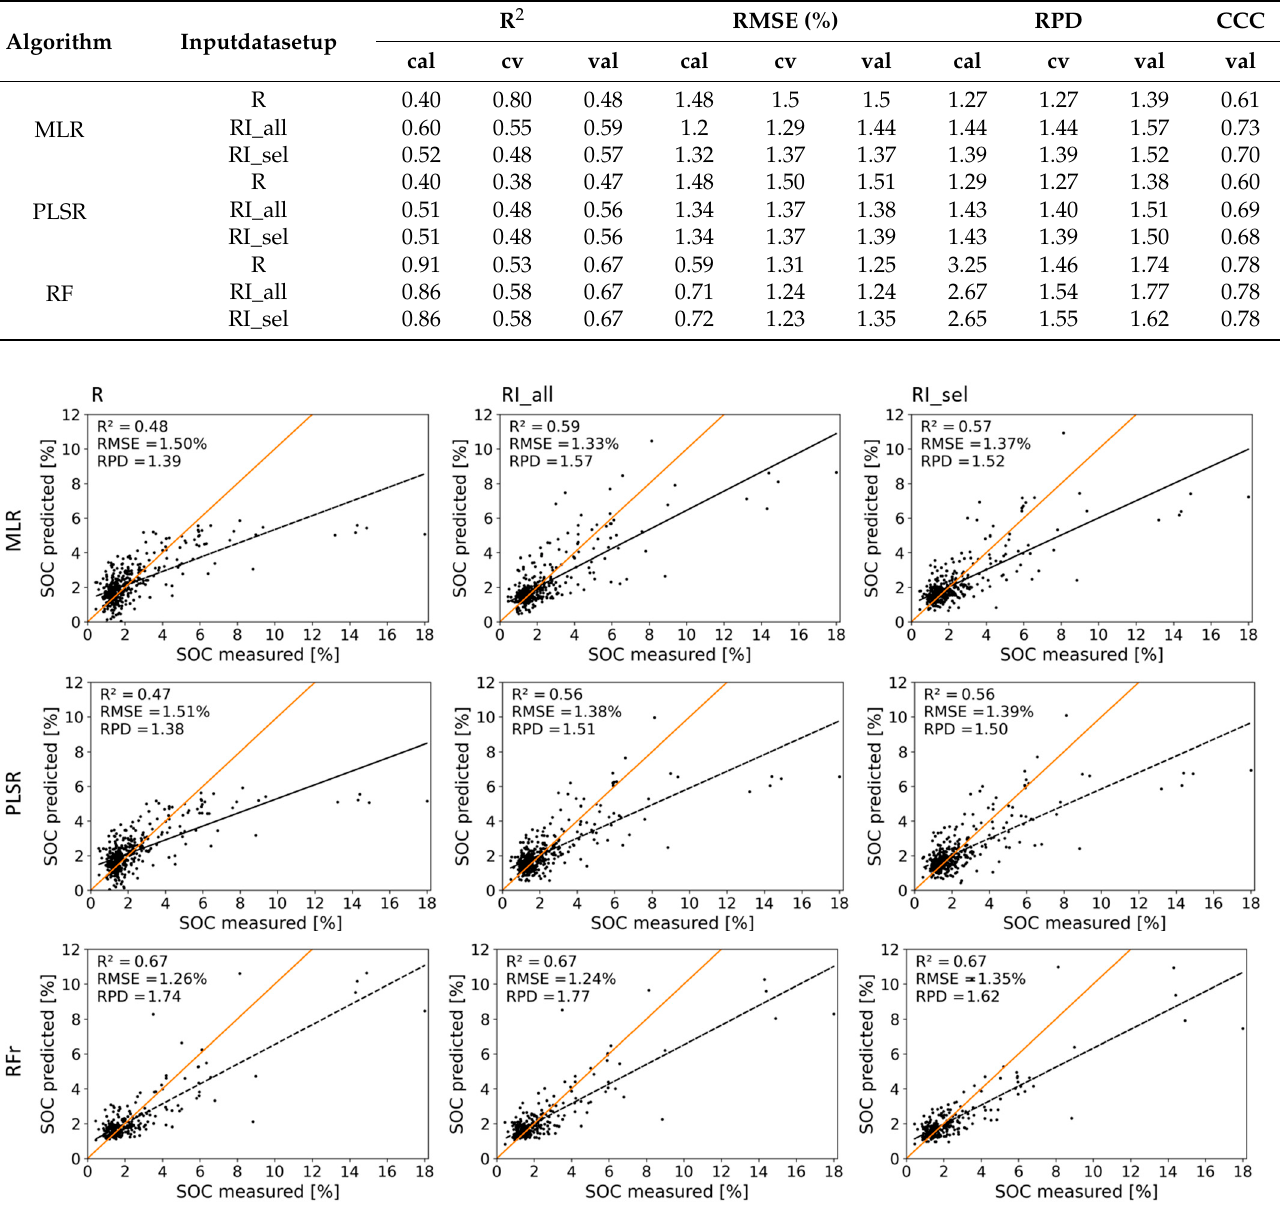
Figure 8. A comparison of predicted and measured SOC contents using the 30% validation data from LfU, LfL and LUCAS not used for model calibration. Depicted are MLR ( upper row ), PLSR ( middle row ) and RF ( bottom row ) based on reflectances (R), reflectances and all indices (RI_all) and reflectances and per algorithm selected indices (RI_sel). The accuracies (R², RPD, RMSE) per algorithm and dataset, the regression (black line) and the 1:1 line (orange) are given.